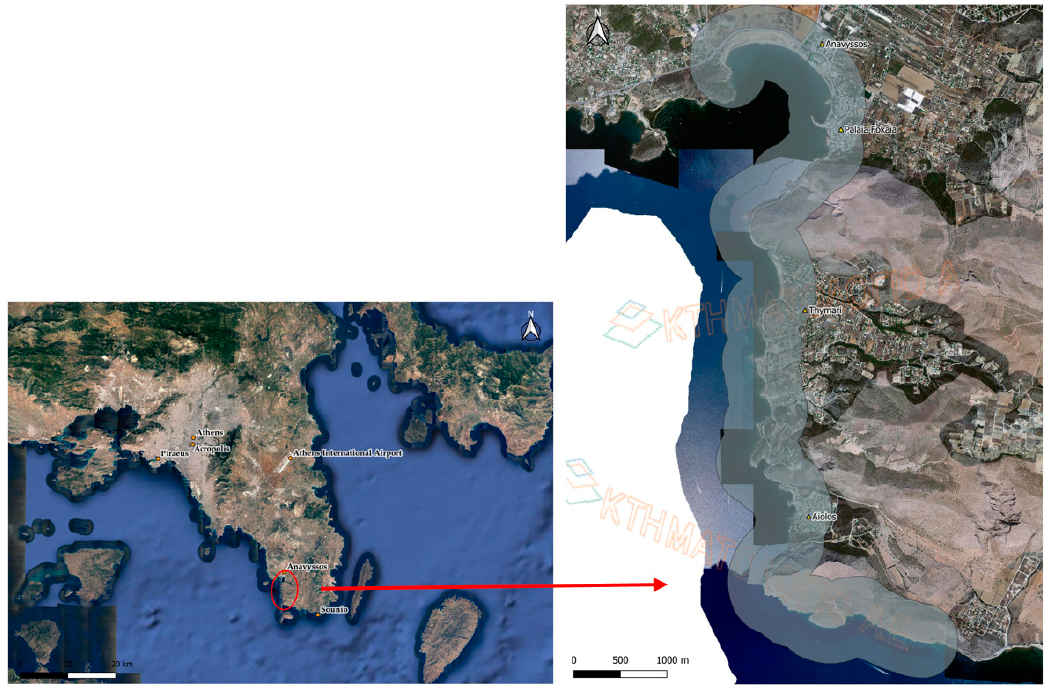
Figure 2. Case study area—a part of the Athenian Riviera. Source: own elaboration.